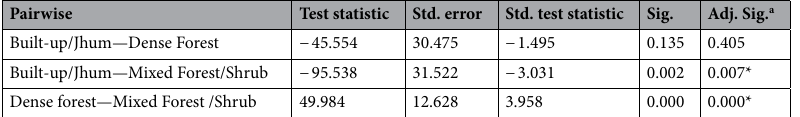
Table 1. Pairwise comparisons (Kruskal–Wallis H test) of land use and malaria cases. a Significance values have been adjusted by the Bonferroni correction for multiple tests. *Significant at p < 0.05.